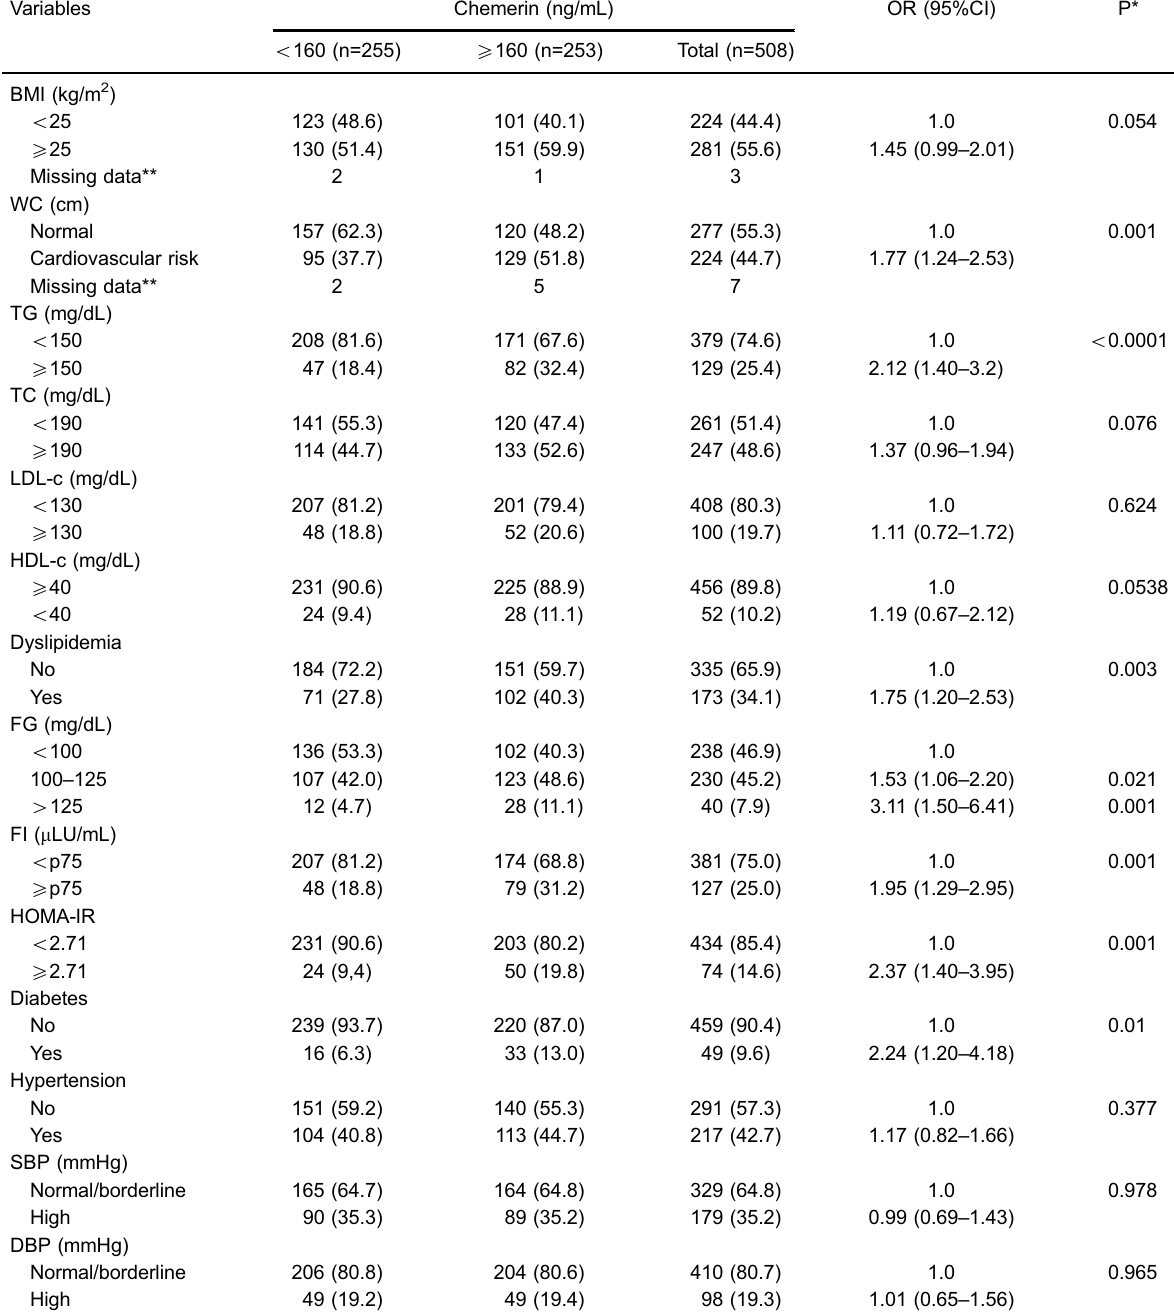
Table 3. Anthropometric, clinical, and biochemical characteristics of the study population by quartiles of